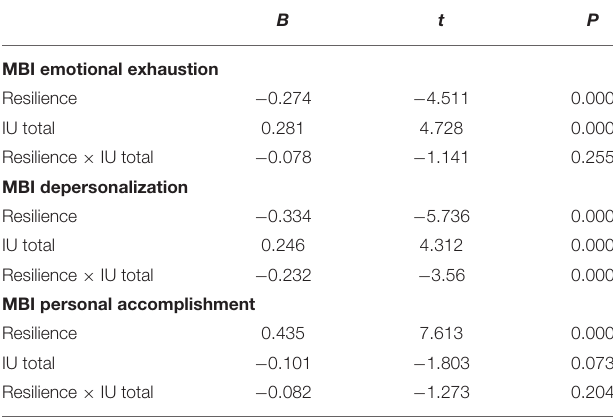
TABLE 6 | General linear models: principal and interactive effects of resilience and intolerance of uncertainty (total score) on burnout dimensions. B